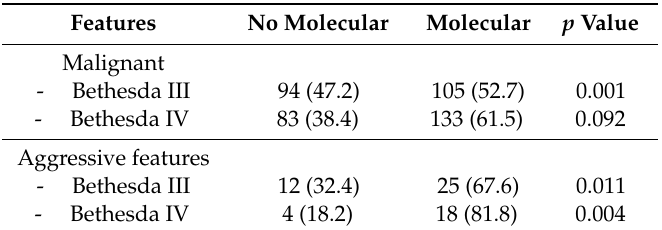
Table 3. Comparing malignancy rates and risk of aggressive features between nodules that did and did not undergo molecular genetic